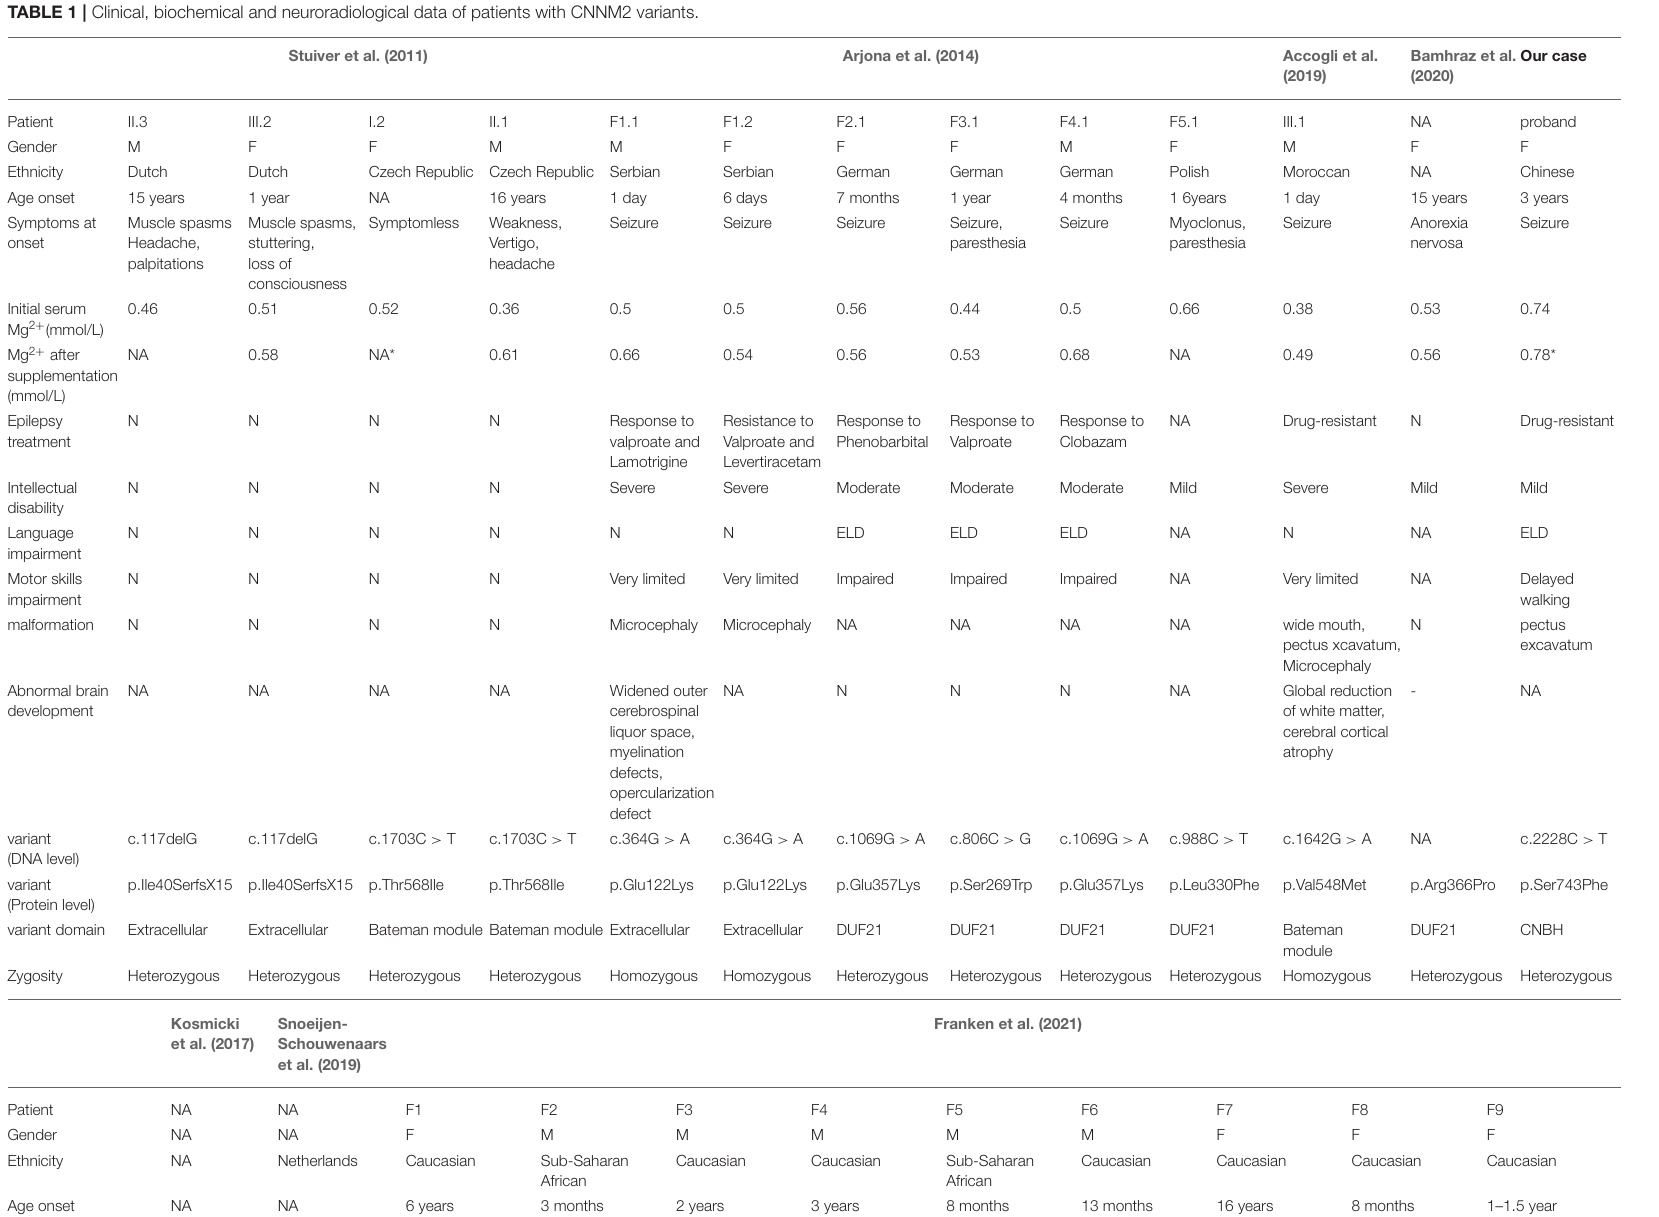
TABLE 1 | Clinical, biochemical and neuroradiological data of patients with CNNM2 variants. Stuiver et al. (2011)